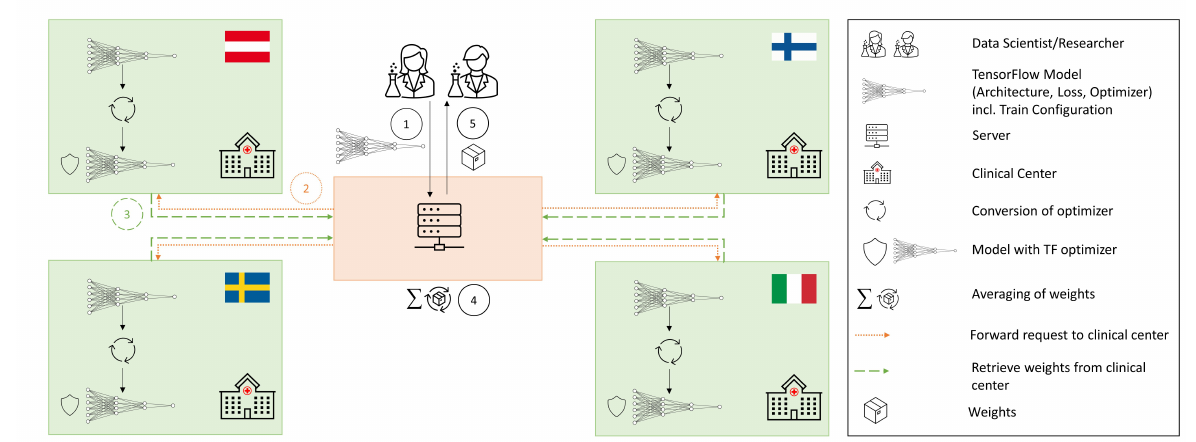
Figure 1. Federated Learning in the context of LETHE: (1) the data scientist sends his/her model to a central server; (2) the server forwards request (model architecture, optimiser, loss, training configuration) to the appropriate clinical centres; (3) clinical centres send their weights after training back to the server; (4) the server averages the weights with FedAVG; (5) after the client rounds, defined in the header of the data scientist’s request, have been reached, the final weights are returned to the data